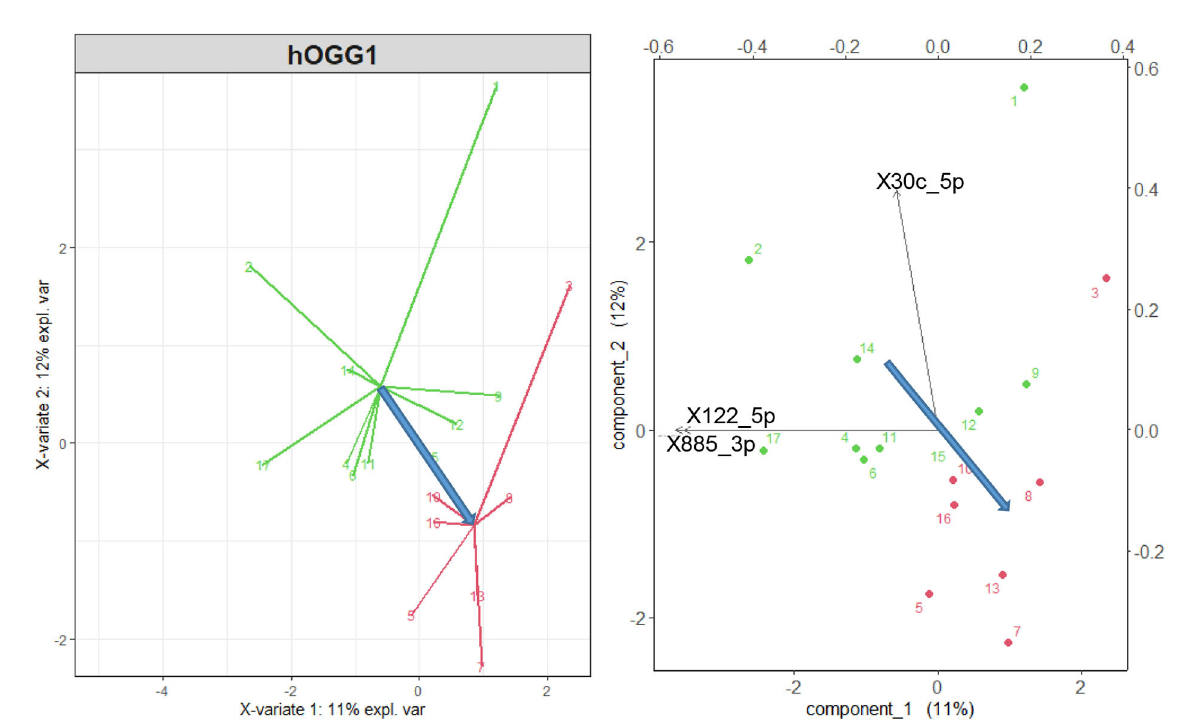
FIGURE3 Left: sPLS-DA wt variant of the gene hOGG1 (green points and arrows) vs. mut and het variant (red), considering all the 56 differentially expressed microRNAs of Sisto et al. (17). Right: representation of the original variables in the 2d space of the transformed variables. Only the three microRNAs with a correlation higher than 0.75 are shown by the black arrows. The blue arrows represent the direction of maximal discrimination between the two groups.